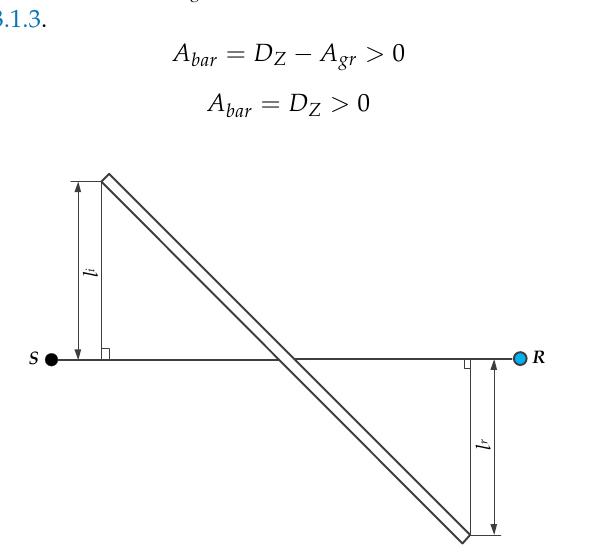
Figure 4. Obstacle between the source ( S ) and the receiver ( R ).